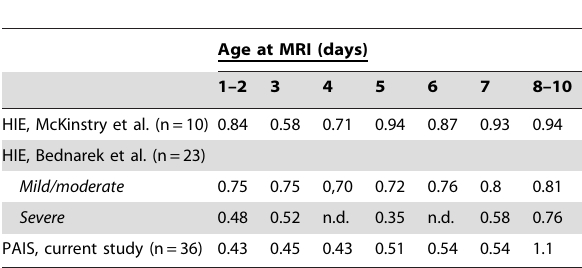
Table 2. Median rADC values of infants with HIE as reported by McKinstry et al. [10] and Bednarek et al.